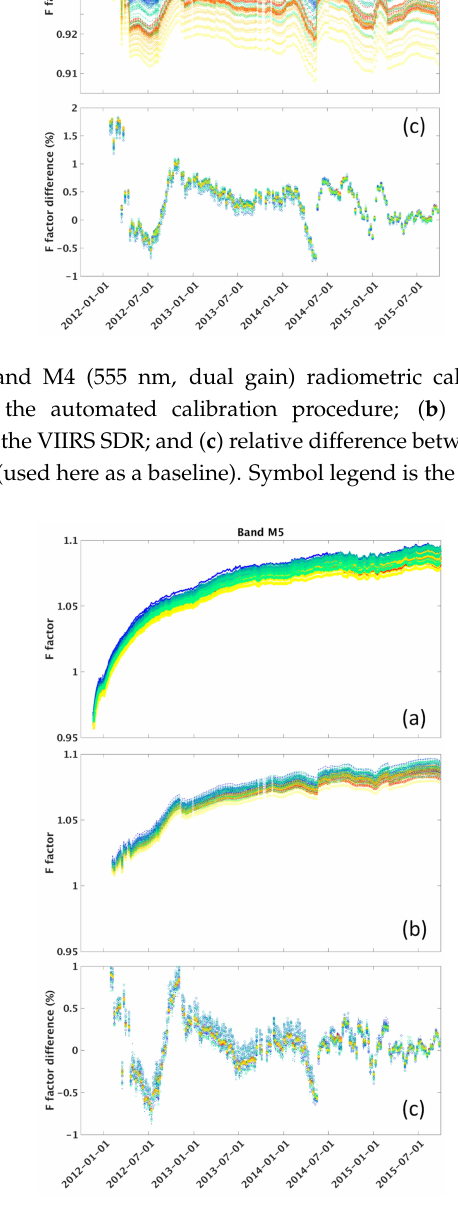
Figure A4. ( a ) VIIRS band M5 (672 nm, dual gain) radiometric calibration scaling coefficients (the F factors) derived by the automated calibration procedure; ( b ) the F factors used in the operational production of the VIIRS SDR; and ( c ) relative difference between the operational F factors and the reprocessed ones (used here as a baseline). Symbol legend is the same as in Figure 4.